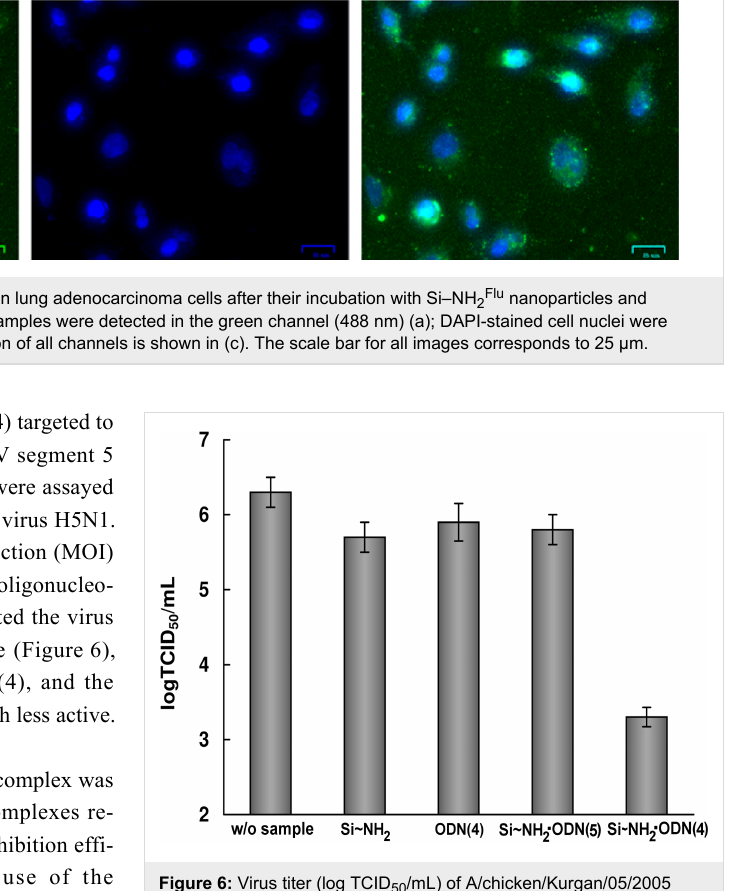
Figure 6: Virus titer (log TCID 50 /mL) of A/chicken/Kurgan/05/2005 virus (H5N1) in the presence of the samples from this study. Experi- ments were performed in three independent